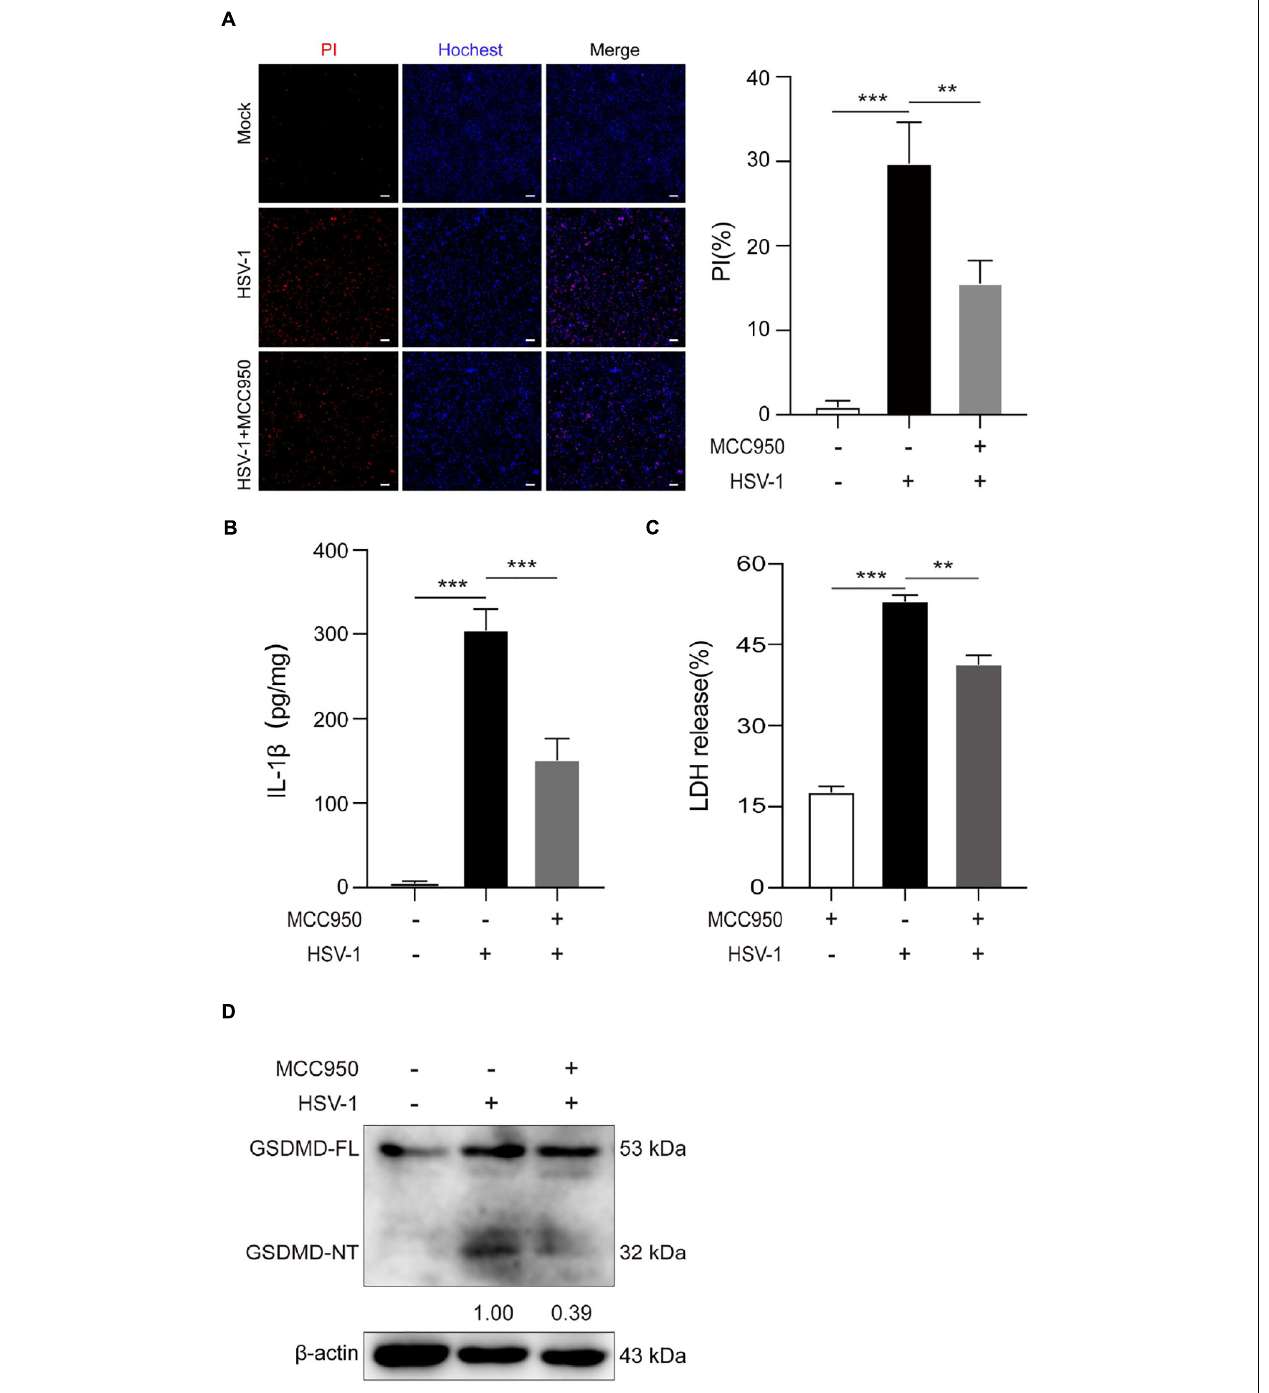
FIGURE 4 | NLRP3-specific inhibitor MCC950 inhibits HSV-1 induced pyroptosis. (A) Cells were stained by Hoechst 33342 (blue; for all cells) and PI (red; for dead cells) for 10 min. All images were captured by fluorescence microscopy, and the merged images show PI and Hoechst 33342 fluorescence with bright-field images. One set of representative images of three independent experiments is shown (scale bars, 100 µ m, 10 × ). PI-positive cells in five randomly chosen fields (one field per well) were quantified. The percentage of cell death is defined as the ratio of PI-positive relative to all (revealed by Hoechst 33342) cells. (B) ELISA of IL-1 β in the supernatants of BV2 cells pretreated with MCC950 (5 µ g/mL) for 1 h and subsequently infected with HSV-1 (MOI = 5) for 24 h. (C) BV2 cells pretreated with MCC950 (5 µ g/mL) for 1 h and LDH release was measured in supernatant derived from MCC950, HSV-1 (MOI = 5) and HSV-1 + MCC950 (5 µ g/mL). (D) BV2 cells were treated as (C) in the presence of MCC950, and the total DNA and protein of HSV-1 were extracted for analysis. Immunoblot analysis of extracts of BV2s by the indicated antibodies. All data are presented as mean ± SD, Student’s t -test, ** P < 0.01, *** P < 0.001.